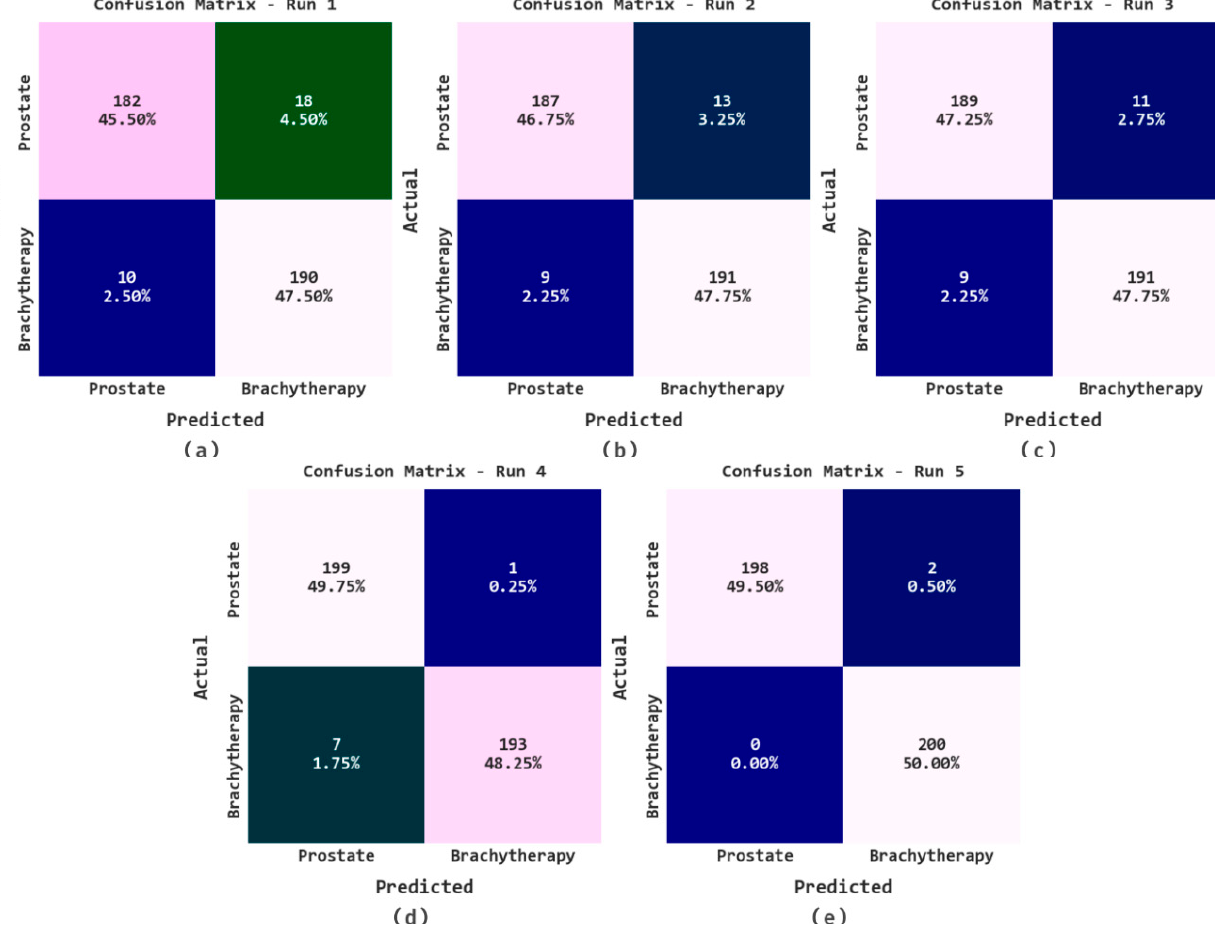
Figure 4. Confusion matrices of the proposed AOADLB-P2C system: ( a ) Run-1, ( b ) Run-2, ( c ) Run-3, ( d ) Run-4, and ( e ) Run-5. Table 2. Analytical results of the AOADLB-P2C system under distinct measures and